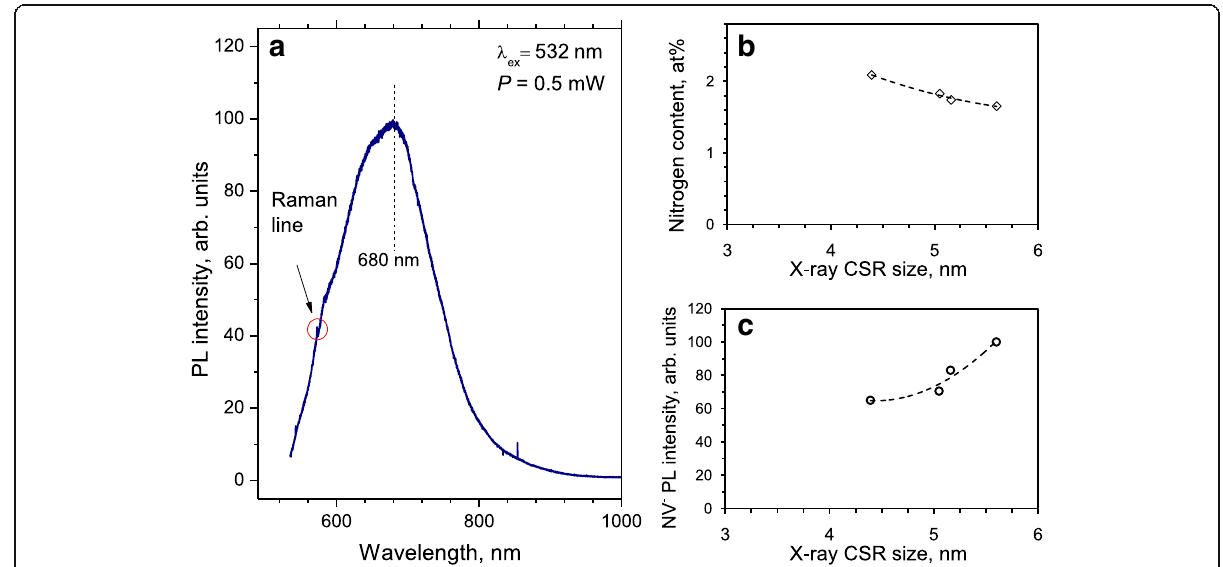
Fig. 6 a Photoluminescence spectrum of DND powder pressed flush in a shallow hole with a diameter of 2 mm made in a copper plate and b the interior nitrogen content measured by XPS and c the intensity of NV − PL at 680 nm as a function of X-ray CSR size for a series of selected DNDs synthesized in the presence of some intentionally added inorganic additives in the detonation zone (charge and water shell) as provided by the manufacturer. Excitation laser wavelength λ = 532 nm, power ~ 0.5 mW. The diameter of the focused laser spot on the sample surface was 2 μ m. Conditions of recording were temperature T = 293 K, and an air